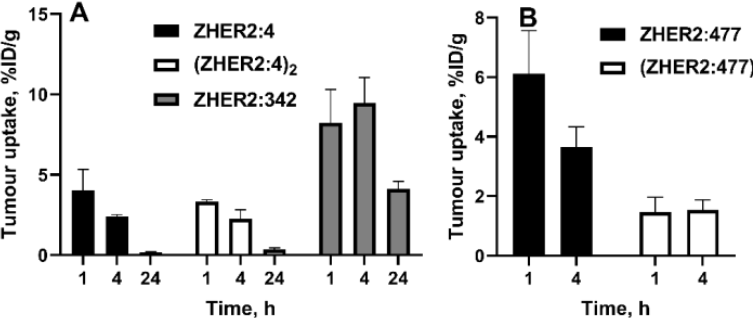
Figure 5. Effect of the dimerization of affibody molecules ZHER2:342 ( A ) and ZHER2:477 ( B ) on the uptake in HER2-expressing xenografts in mice. Index 2 in designations (ZHER2:4) 2 and (ZHER2:477) 2 shows that these affibody constructs contain two monomeric units fused head-to-tail. Data are taken from [22] and [72].